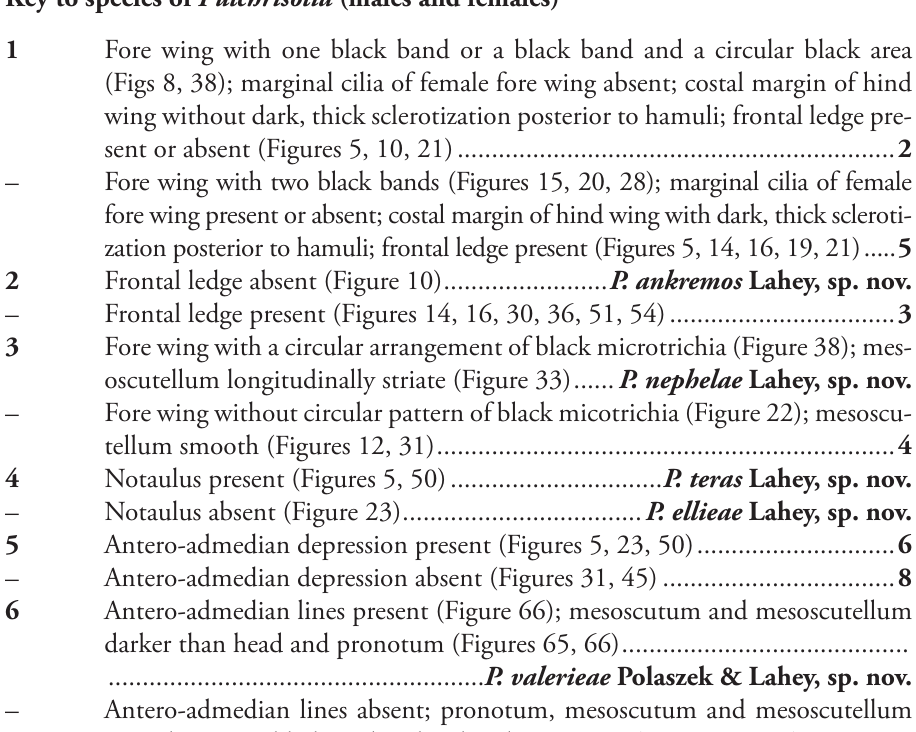
1 Microtrichia of fore wing distinctly bicolored, giving the appearance of patches or stripes (Figures 1, 2, 48, 64) ....................................................... 2 – Microtrichia of fore wing not bicolored (Figures 3, 4) ................................. 3 2 Fore wing with short, tubular submarginal vein terminating in knob (Figs 1, 5, 23, 31, 38); microtrichia on fore wing in the form of scale-like pegs (Figs 1, 12, 31, 38); mesoscutum longer than visible portion of pronotum in dorsal view (Figures 5, 23, 50); S2 glabrous; inner margin of metatibia with comb of setae (Figures 15, 22) ........................................ Pulchrisolia Szabó – Fore wing veinless (Figure 2); microtrichia on fore wing dense, overlapping, and needle-like (see Masner and Huggert 1989, p. 197); S2 with long setae; mesoscutum transverse, shorter than visible portion of pronotum (Figure 2); inner margin of metatibia without comb of setae ........ Sceliotrachelus Brues 3 Fore wing with tubular submarginal vein (Figure 3); transepisternal line pre- sent; anterior notaular pits present (Figure 3) .. Afrisolia Masner & Huggert – Fore wing veinless (Figure 4); transepisternal line absent; anterior notaular pits absent (Figure 4) ............................................................... Isolia Förster